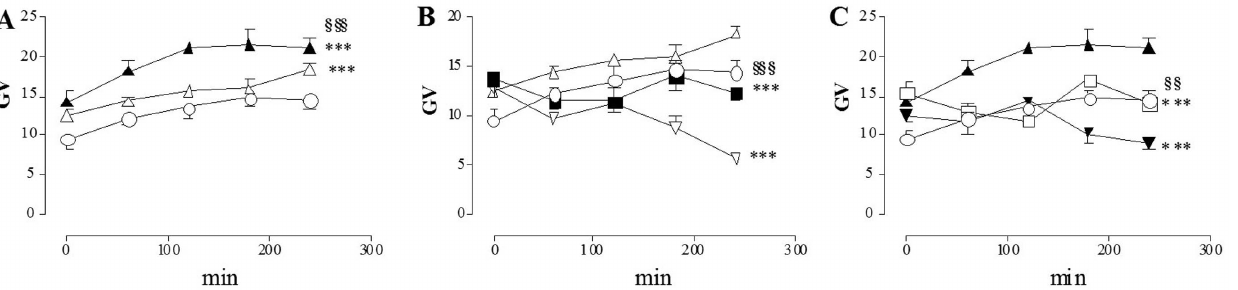
Figure 7. Effect of -AP5 and CNQX on ROS generation in myenteric neurons following I/R damage. Graphs indicate the extent and timescale of free radical generation (GV 5 mean grey value of HPF fluorescence intensity) in enteric neurons, in normal metabolic conditions ( # ), after chemical ischemia ( n ) and after reperfusion ( m ) in the absence of any drug (A); in normal metabolic conditions ( # ), after chemical ischemia ( n ) in the presence of -AP5 500 m M ( & ) and of CNQX 100 m M ( , ) (B); in normal metabolic conditions ( # ), after reperfusion ( m ) in the presence of -AP5 100 m M ( % ) and of CNQX 500 m M ( . ) (C). Each point represents the mean of at least 3 experiments. Vertical bars indicate S.E.M. (A) *** P , 0.001 vs normal metabolic conditions, $$$ P , 0.001 vs chemical ischemia conditions; (B) *** P , 0.001 vs chemical ischemia only, 111 P , 0.001 vs CNQX 100 m M; (C) *** P , 0.001 vs reperfused preparations only, 11 P , 0.01 vs CNQX 500 m M by two-way